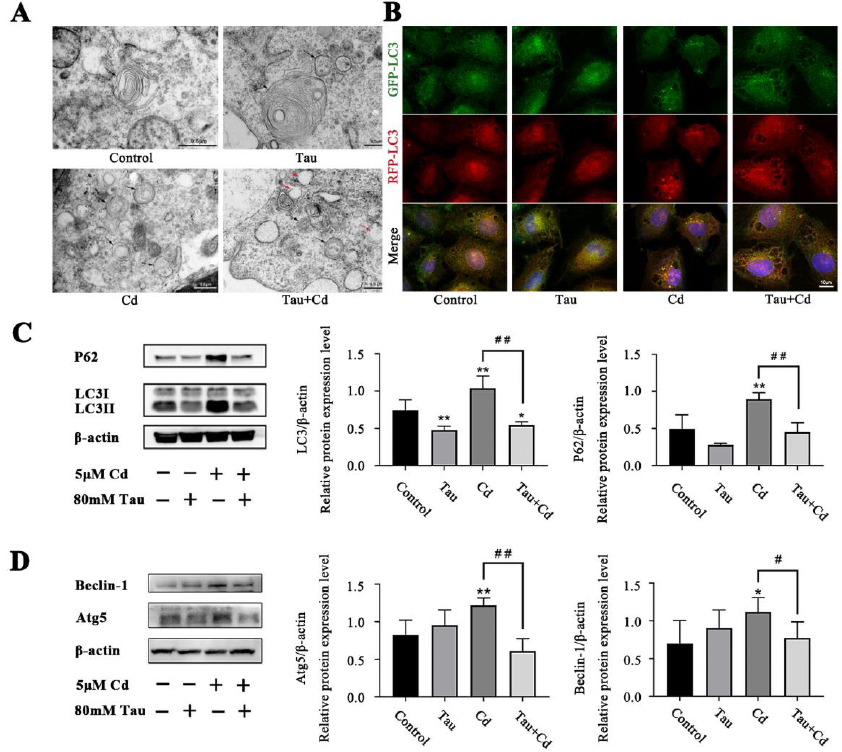
Figure 2. Tau can alleviate Cd − induced autophagy flux arrest in BRL3A cells. ( A ) Effect of Tau and Cd on autophagosomes and autolysosomes in BRL3A cells (scale bar = 0.5 μm). The autophagosomes and autolysosomes were marked with black and red arrows. ( B ) Effect of Tau and Cd on RFP − GFP − LC3 fluorescent protein expression in BRL3A cells (scale bar = 10 μm). ( C ) Effect of Tau and Cd on the levels of LC3 and P62 proteins in BRL 3A cells. ( D ) Effect of Tau and Cd on the protein levels of Atg5 and Beclin − 1 in BRL 3A cells. Compared with the Control group, * p < 0.05 and ** p < 0.01. Compared with the Cd − treated group, # p < 0.05 and ## p < 0.01.